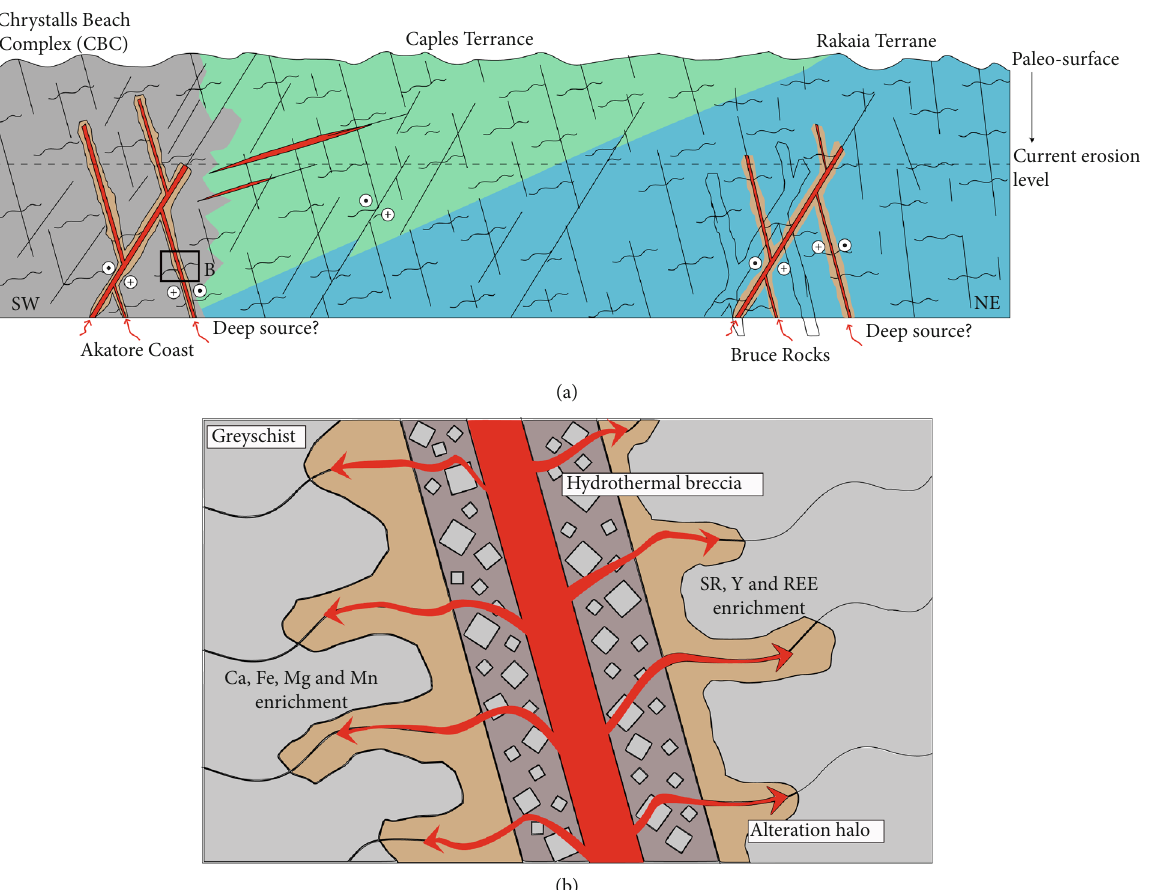
Figure 10: Cartoon interpretation of the formation of the shallow hydrothermal systems at Akatore Creek and Bruce Rocks. (a) Cross-section of the Otago Schist, showing reactivation of Late Cretaceous exhumation joints as post-Early Miocene brittle fault networks that resulted in strongly channelized shallow fl uid fl ow. (b) Structural controls on fl uid fl ow include preferential fl ow along faults (reactivated joints) and the Mesozoic foliation, causing enrichment in Ca, Fe, Mg, Mn, Sr, Y, and REE within the alteration